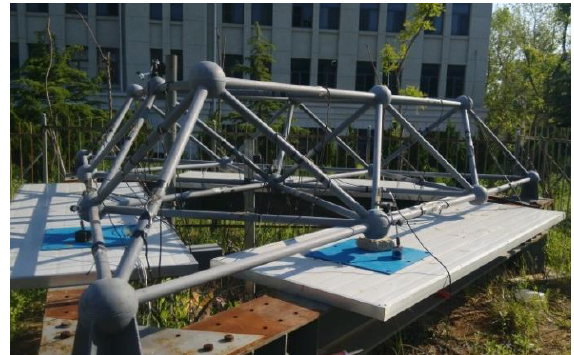
Figure 2. The arrangement of the measuring points of the test model. Black boxes indicate the cross plate supports.